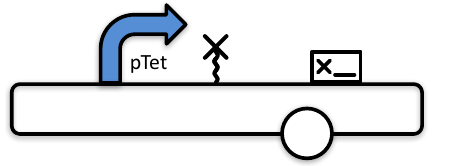
Figure 32: Circular plasmid containing a pTet promoter followed by a ribonuclease site. In addition, the plasmid has been bar-coded with a signature and has its origin of replication marked.